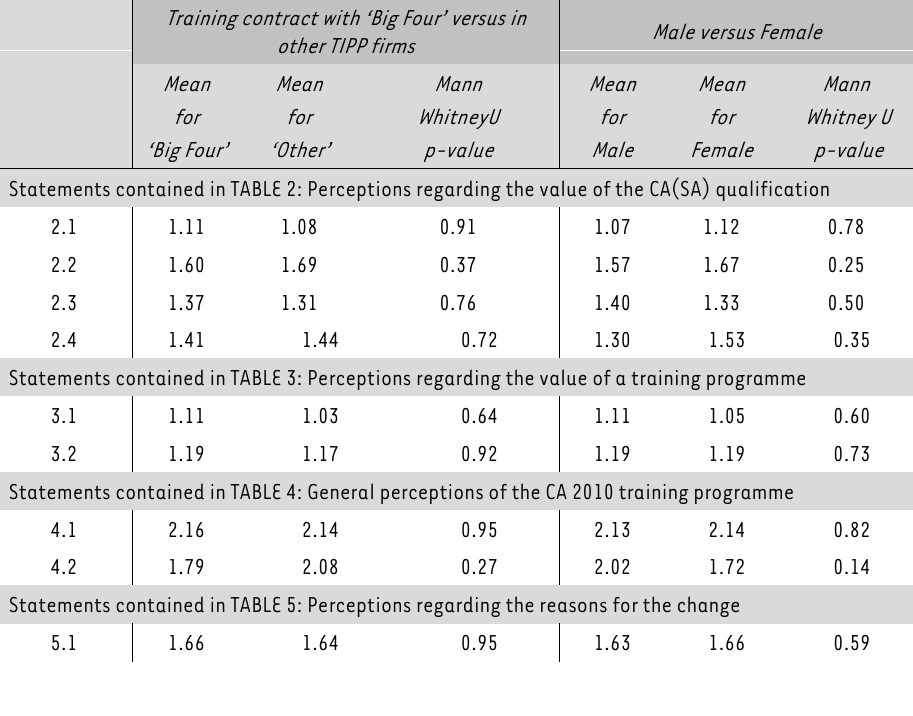
Comparing responses from students (different training offices and genders) Training contract with ‘Big Four’ versus in other TIPP firms Mean Mean for for ‘Big Four’ ‘Other’